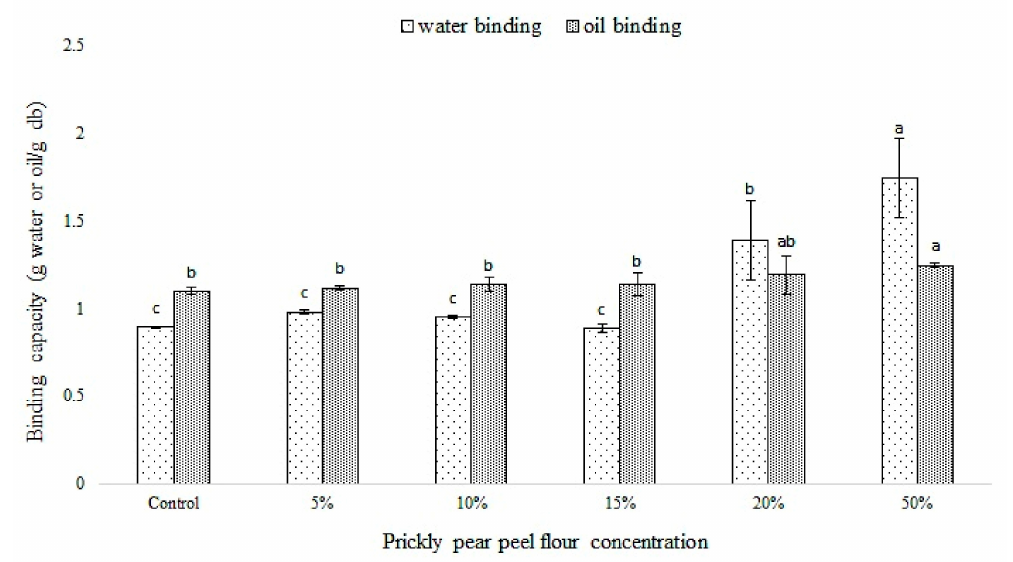
Figure 1. Water and oil absorption capacity of di ff erent blend performed with durum wheat flour and 5, 10, 15, 20 or 50% of prickly pear peel flour (PPPF). Control was made with durum wheat flour, without any PPPF addition. Within the same parameters (water binding or oil binding), columns followed by di ff erent letters are significantly di ff erent according to Fisher’s least significant di ff erence test ( p < 0.05). Vertical bars indicate the standard deviation of the